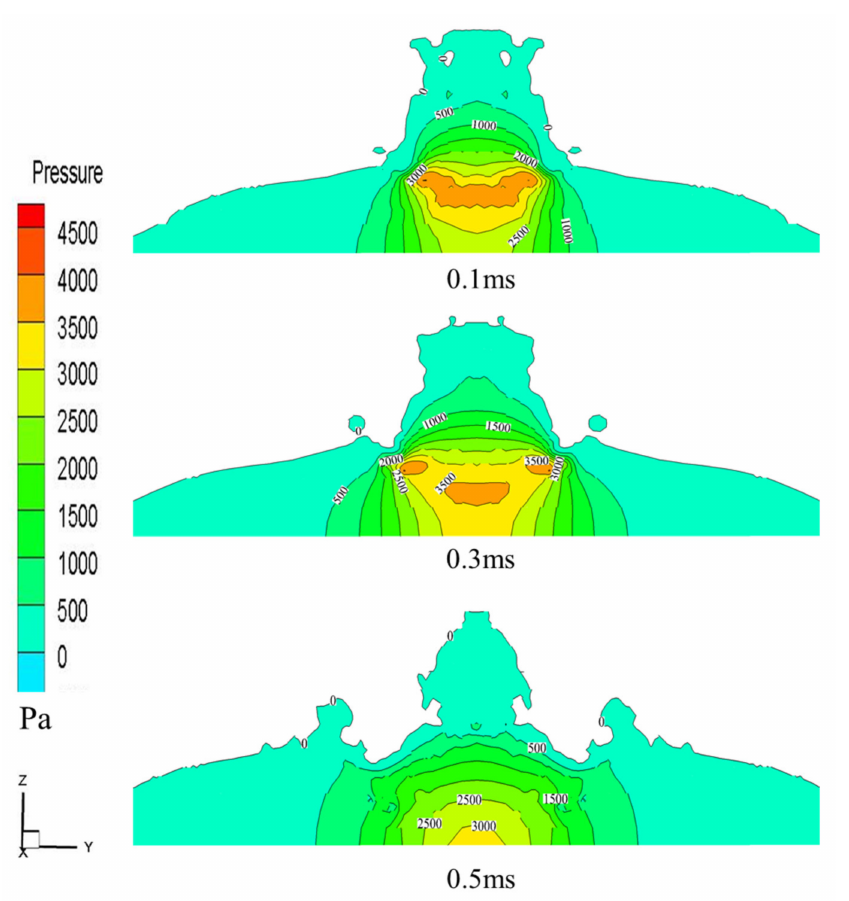
Figure 4. The pressure contour of a droplet’s initial impact on the liquid film at x = 0.01 m